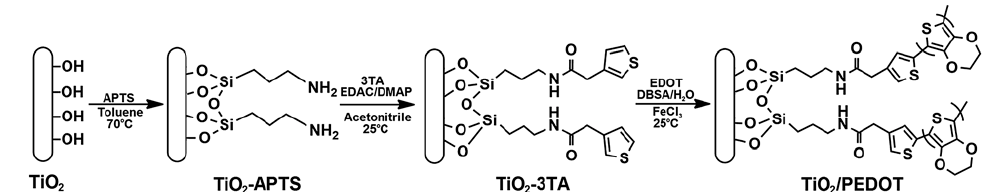
Figure 4. TEM images of ( a , b ) PS and PS/PEDOT (An et al. [87], © Elsevier, 2007); ( c , d ) nanorod-TiO 2 and nanorod-TiO 2 /PEDOT (Eroal et al. [88], © The Royal Society of Chemistry, 2015); ( e , f ) SiO 2 and PEDOT/SiO 2 (Park et al. [89], © Elsevier, 2018); ( g , h ) nanocube-TiO 2 and nanocube-TiO 2 /P3OT (Sever et al. [90], © Elsevier,